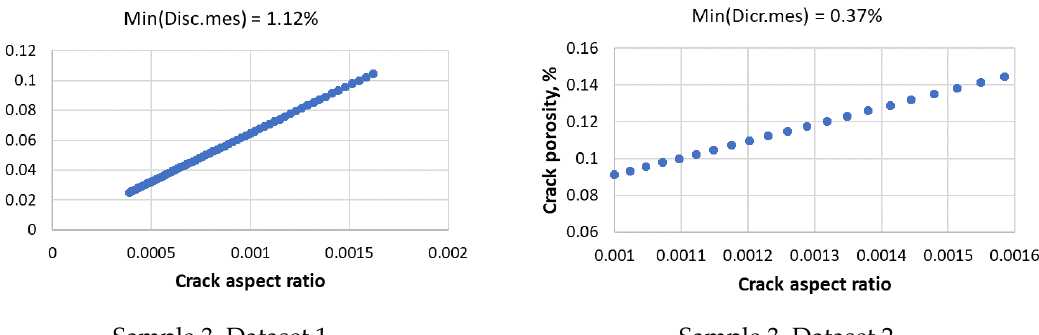
Figure 13. Examples of solutions for conditional minimum for Sample 3. The value of conditional minimum is shown in the plot’s caption.